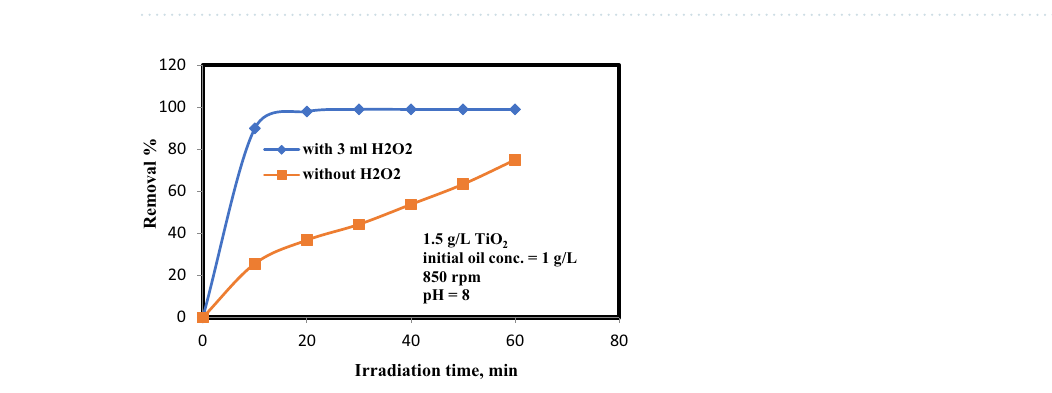
Figure 10. The reaction rate of 1 g/L initial oil concentration at optimum operating parameters. ( a ) First order equation ( b ) Second order equation.